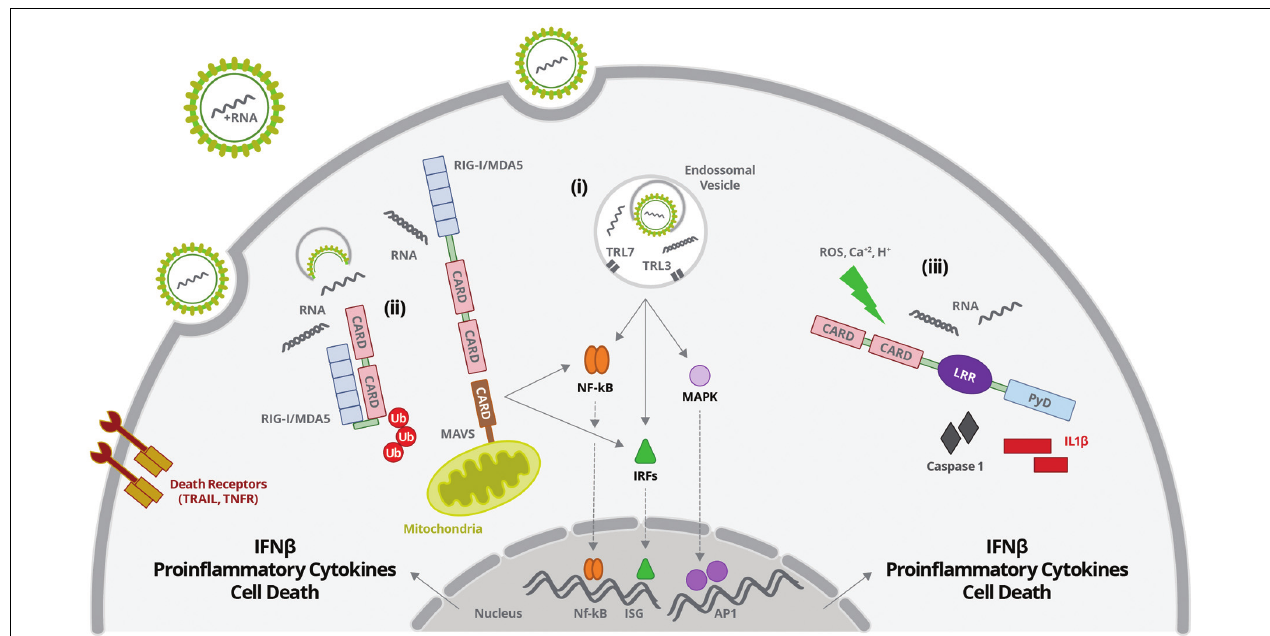
FIGURE 1 | Flavivirus entry and uncoating is followed by virus RNA sensing by: (i) TLR3 and 7 present in endosomal vesicles; (ii) RIG-I or MDA5 at the cytoplasm; (iii) NOD-like receptors (NLR) at the cytoplasm. (i) ssRNA or dsRNA are sensed by TLR7 or TR3, respectively. TLR activation leads to activation of IRFs, NF- κ B, and MAPK and their translocation to the nucleus, inducing the production of interferons, proinflammatory cytokines and cell death. (ii) dsRNA sensing by RIG-I induces a conformational change of CTD, allowing exposition of CARD. CARD domain is then targeted by the ubiquitin ligases, which promotes its polyubiquitination and MAVS recruitment. RIG-I/MAVS activation promotes activation of IRFs, NF- κ B, and MAPK and their translocation to the nucleus, inducing the production of interferons, proinflammatory cytokines and cell death. (iii) RNA sensing together with other stress signals (ROS, increased Ca 2 + and/or H + ) activates inflammasome complexes, inducing caspases 1/11 activation and IL-1 β and IL-18 secretion.